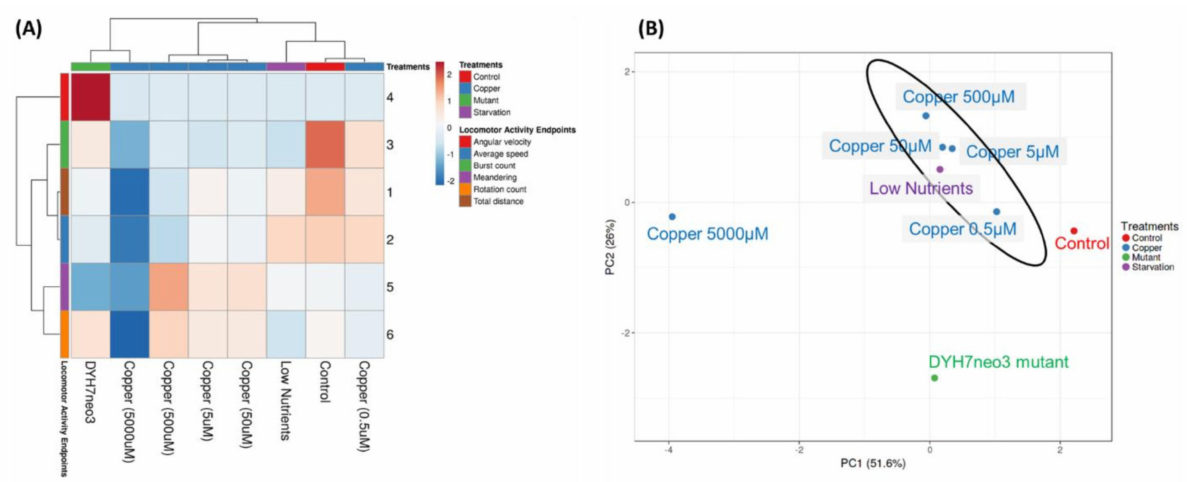
Figure 6. Behavior endpoint comparison in T. thermophila with different treatments. ( A ) Hierarchical heatmap clustering analysis and ( B ) principal component analysis (PCA). Four different treatment groups with following conditions: starvation (low nutrients) is displayed in purple color, copper exposure (0.5; 5; 50; 500; and 5000 µ M) in blue color, mutant (DYH7neo3) in green color, and the untreated group is included as the control (red